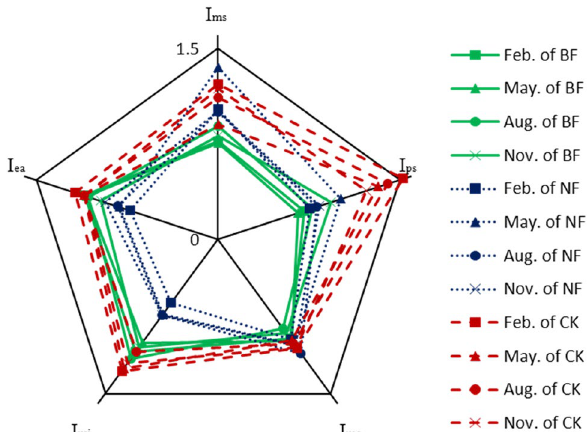
Figure 2. Soil qualities of different slash disposals in GSDFF. BF means burning forest, NF means no-burning forest, CK means the control. I ms means the moisture index, I ps means the porosity index, I ma means the macro- element index, I mi means the minor element index, I ea means the enzyme activity